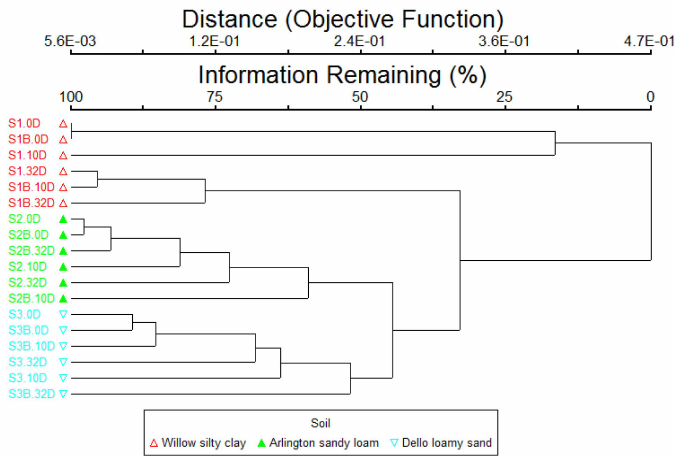
Figure 3. Cluster dendrogram of bacterial community in cucumber rhizosphere by PCORD. Figures next to the branches are cophenetic correlations value that is a parameter to express the consistence of a cluster. (S0D, S10D and S32D indicate soils untreated and sampled in 0, 10 and 32 day. SB0D, SB10D and SB32D indicate B subtilis B068150-NR was introduced in to soils and sampled in 0, 10 and 32